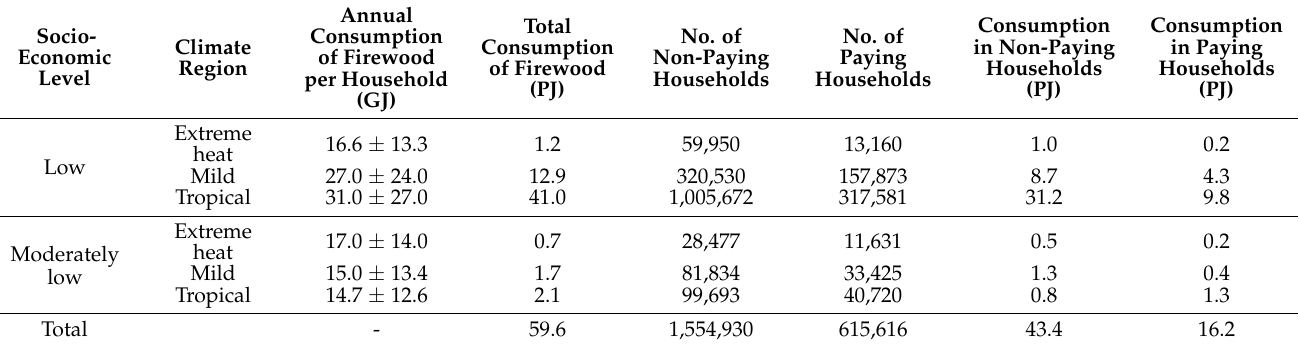
Table 1. Consumption of firewood per household, number of households, and total consumption of firewood in paying and non-paying EFU